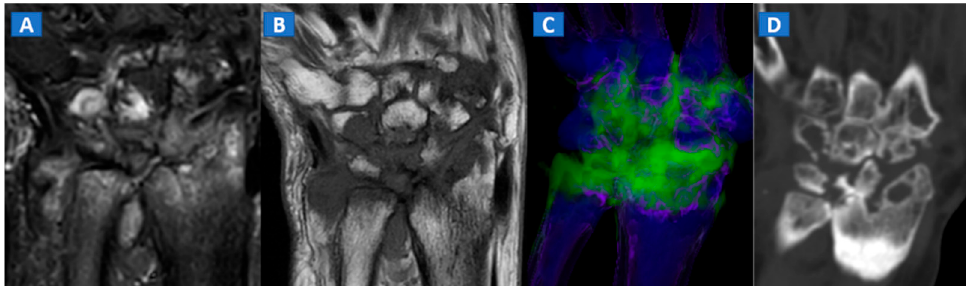
Figure 8. A 59-year-old female with advanced rheumatoid arthritis. On the coronal STIR MRI image ( A ), diffuse BME of the wrist and carpal bone is evident as signal hyperintensity. On the corresponding T1-weighted image ( B ), advanced erosive changes are apparent. On the 3D coronal DECT image ( C ), BME is confirmed. The coronal 1 mm standard CT image with soft tissue window ( D ) allows the depiction of erosive and morphological changes of the carpal bones.